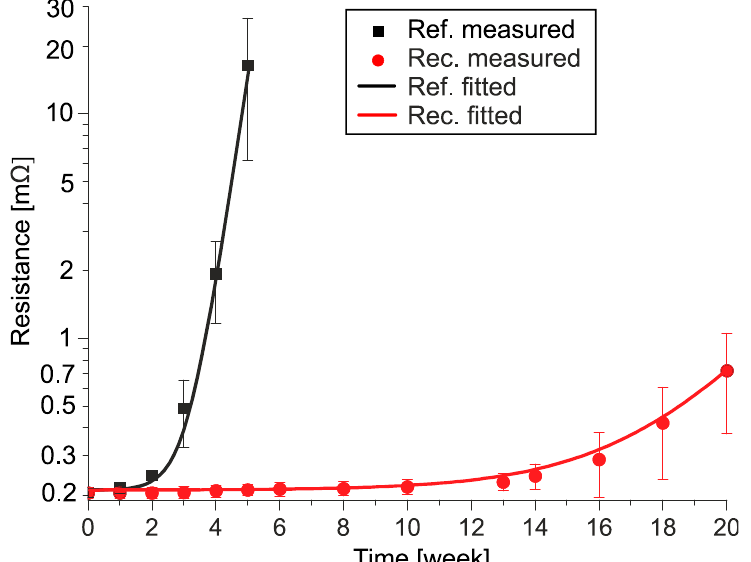
Figure 6. Plot of the electrical resistance changes in the reference (black) and recrystallized (red) samples at − 20 °C, showing measured averages (dots), and fitted curves.